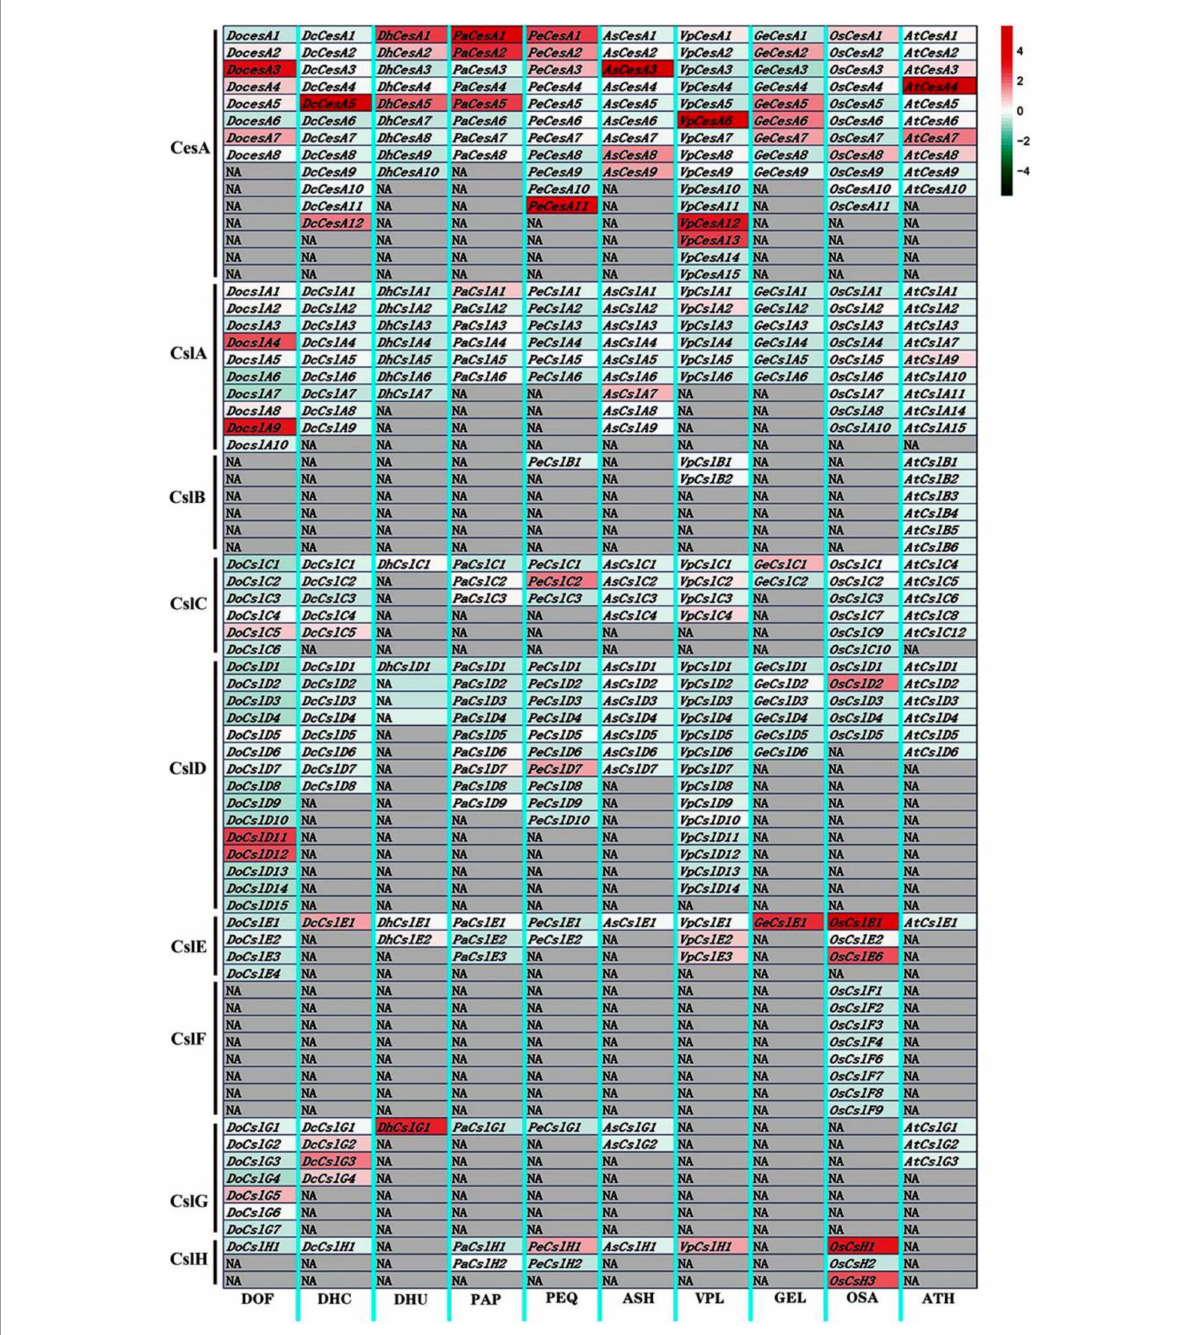
FIGURE4 Heatmap of expression profiles of CesA/Csl genes in stem tissues of nine orchid species. The color bar indicates the expression level (normalized FPKM values) of cellulose synthase genes, with the red color indicating a high expression level, while the blue color represents a low expression level. The gray block indicates NA with no gene. The gene expression was normalized by each column respectively. DOF, D. officinal ; DCH, D. chrysotoxum ; DHU, D. huoshanense ; PAP, P. aphrodite ; PEQ, P. equestris ; ASH, A. shenzhenica ; VPL, V. planifolia ; GEL, G. elata ; OSA, O. sativa ; ATH, A. thaliana.